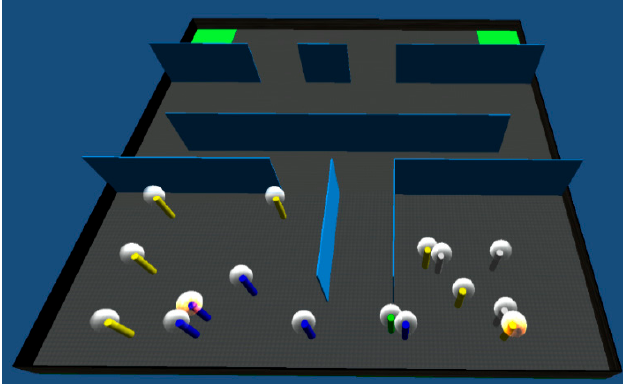
Figure 9. Agents performing different procedures. Yellow: default; blue: information exchange; gray: reconsideration; green: sidestepping.